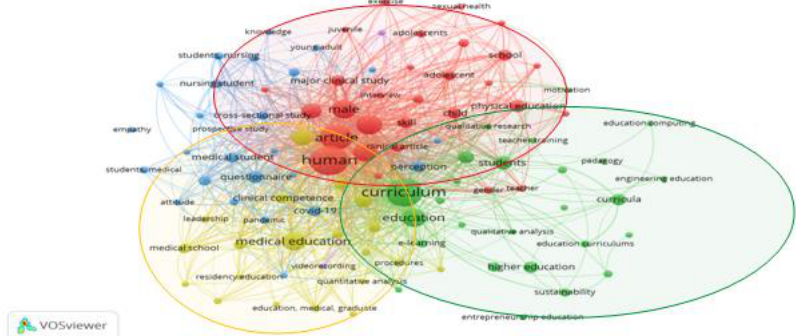
Figure 3 <Keyword Network